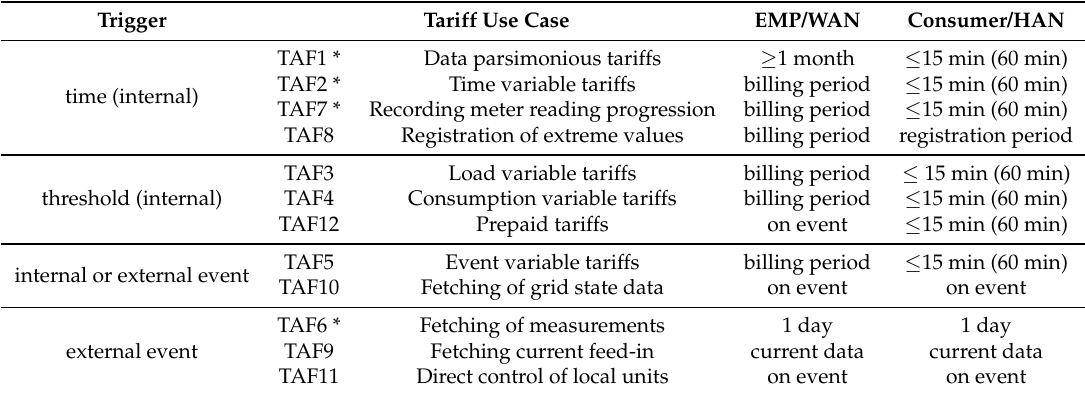
Table 1. Overview of tariff use cases and the respective data availability requirements, based on [7]. The columns for EMP/WAN and Consumer/HAN show the specific minimum (for EMP/WAN) and maximum (for Consumer/HAN) time spans before new data for electricity (gas) is available according to the tariff use case